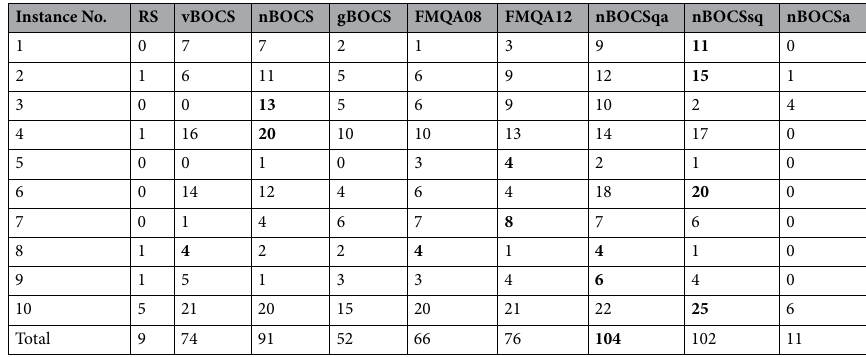
Table 1. Counts of finding exact soulution per 25 runs. The highest values are in bold.